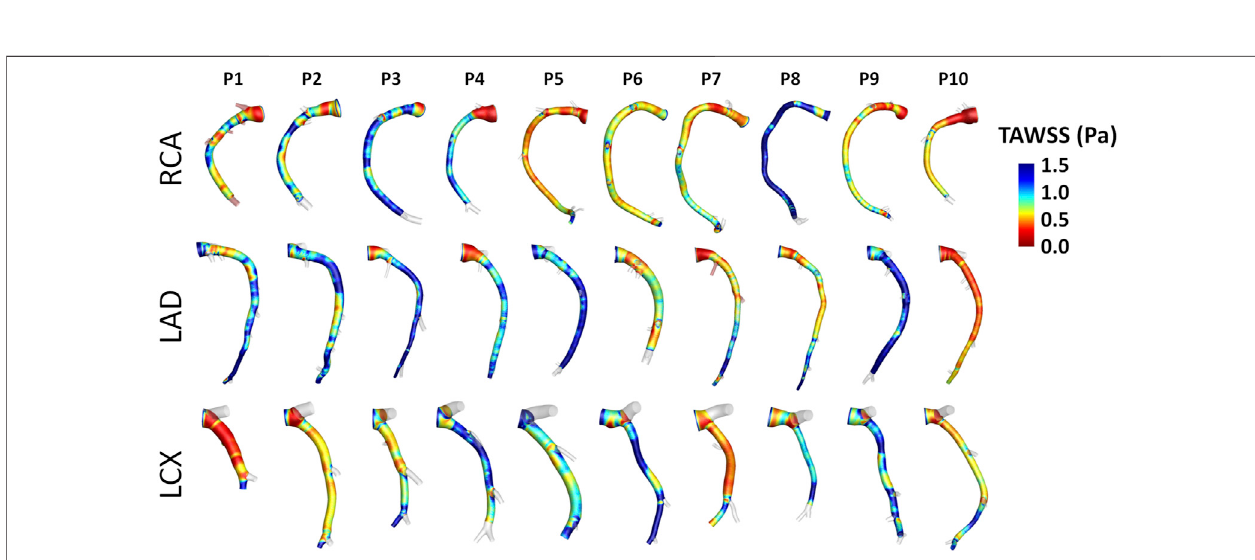
FIGURE8| TAWSSdistribution attheluminalsurfaceofthe30swinecoronaryarteries.RedcolorhighlightsluminalregionsexposedtolowTAWSSvalues.Labels from P1 to P10 identify the single pig. Right (RCA), left anterior descending (LAD), and left circum fl ex (LCX) coronary artery geometries are grouped.